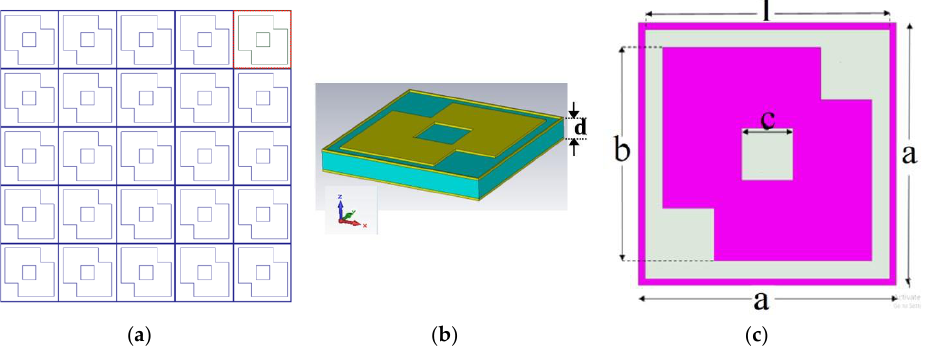
Figure 1. Schematic of the design: ( a ) Two-dimensional (2D) periodic array structure ( b ) Top view (X-Y) ( c ) 3D perspective view.